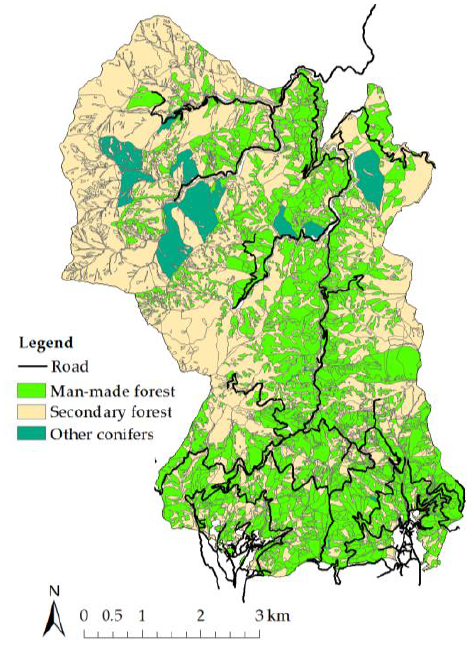
Figure 9. Locality (distance to road) ( a ) and site classes ( b ) in the study area.